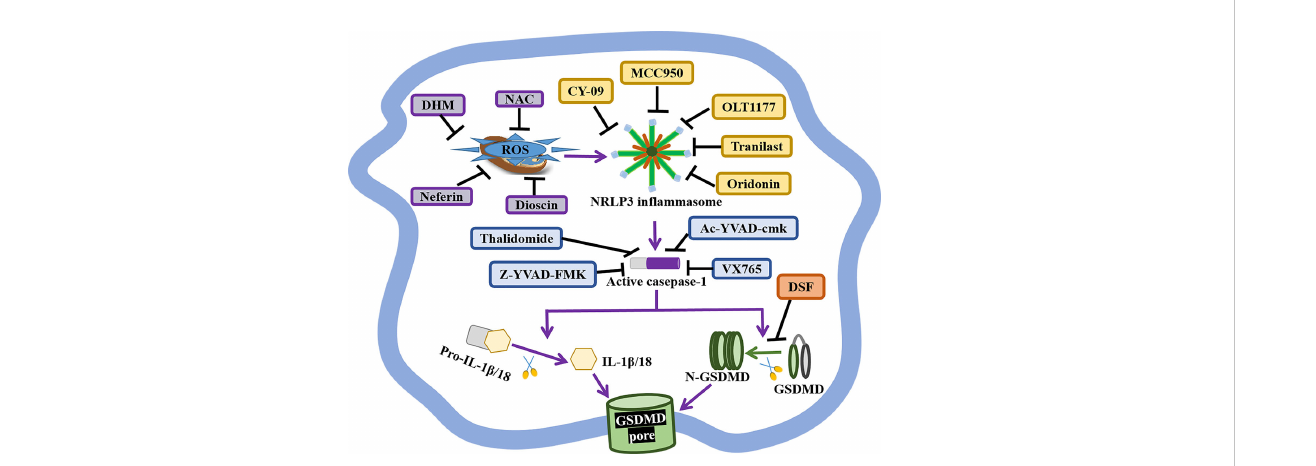
FIGURE 2 The status of GSDMD, NLRP3 in fl ammasome, and caspase-1-related inhibitors. GSDMD, NIRP3 in fl ammasome, and caspase-1 are indispensable in the canonical pyroptosis pathway, and corresponding inhibitors have shown great therapeutical potential for APS. DSF is an inhibitor of GSDMD pores formation. The selective NLRP3 inhibitor MCC950, OLT1177, Tranilast, Oridonin, CY-09 speci fi cally inhibit NLRP3 in fl ammasome activity and pyroptotic cell death. As well, the anti-oxidant Neferine, DHM, NAC and Dioscin block NLRP3-mediated pyroptosis via reducing the production of